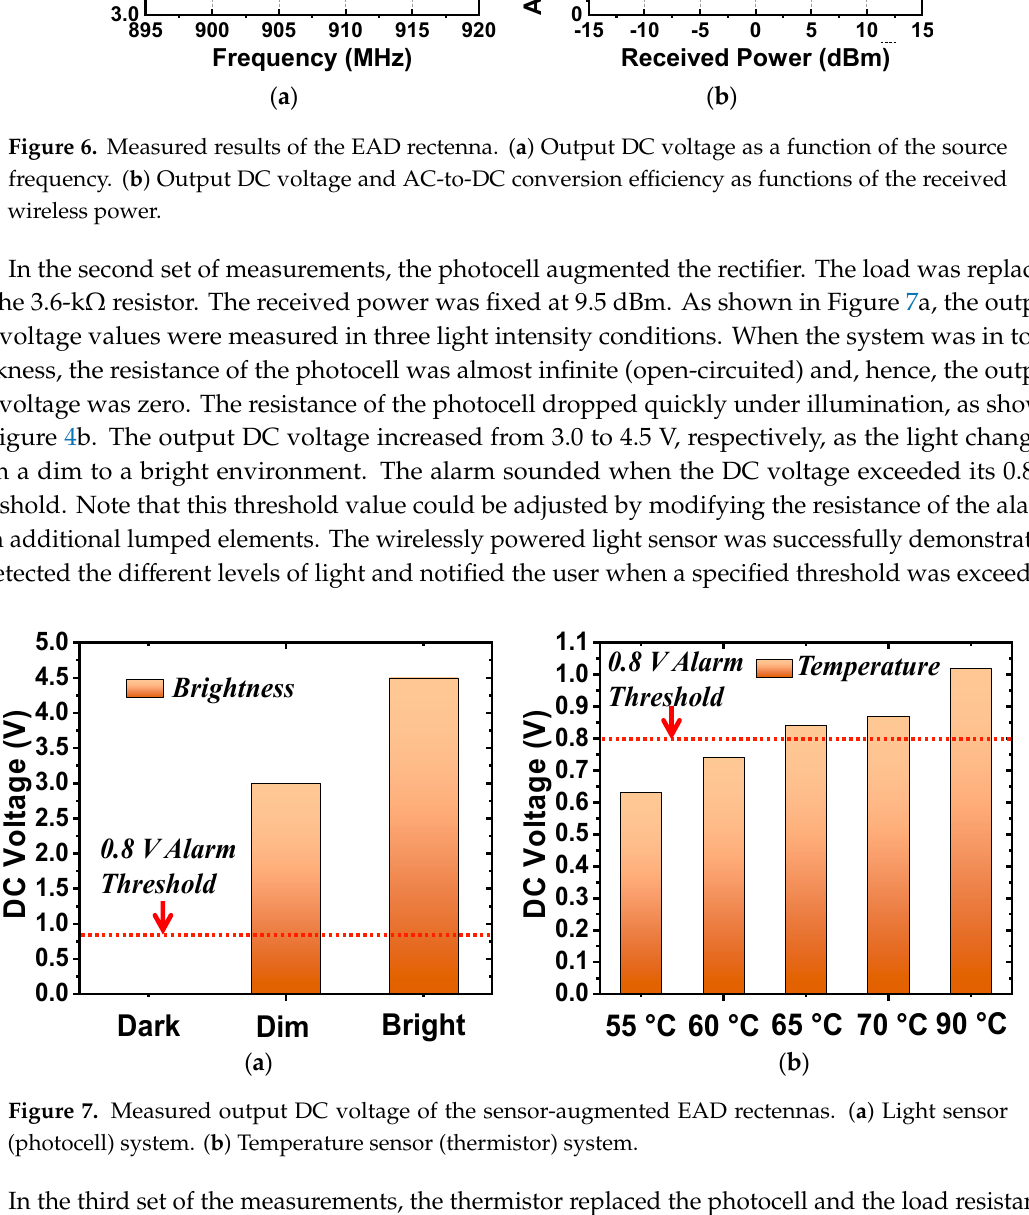
Figure 6. Measured results of the EAD rectenna. ( a ) Output DC voltage as a function of the source frequency. ( b ) Output DC voltage and AC-to-DC conversion efficiency as functions of the received wireless power.